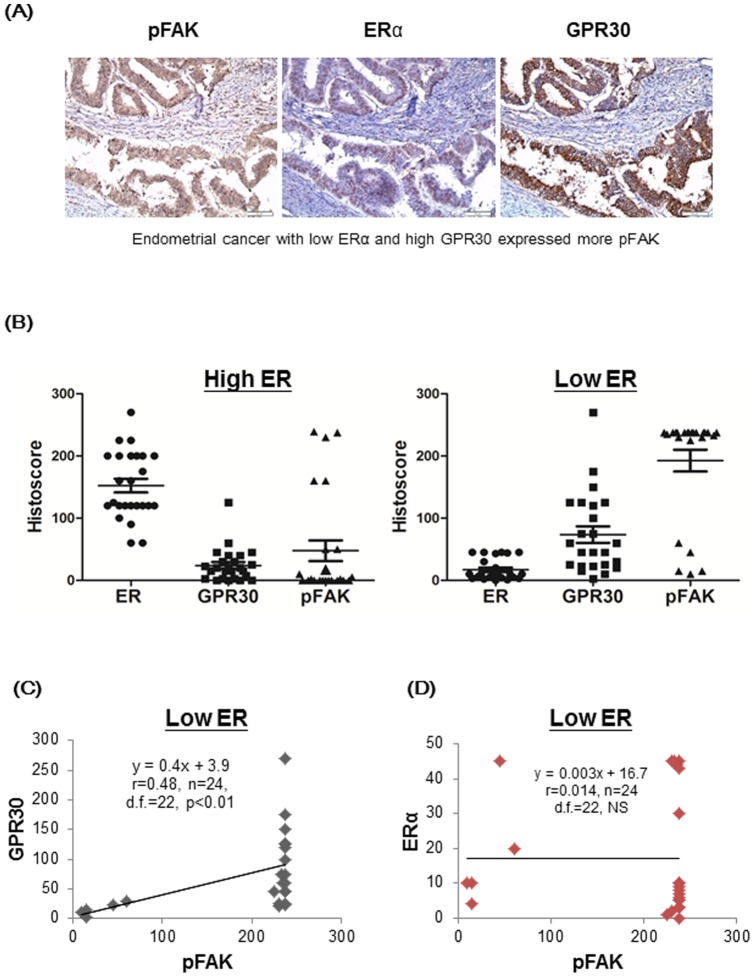
Expression of ERα, GPR30 and pFAK (at Y397) in human endometrial cancers with low ERα.(A) In clinical samples of human endometrial cancers with low expression of ERα (histoscore  = 10), relatively high expression of GPR30 (histoscore  = 270) and pFAK (histoscore  = 225) were observed (40× magnification of the object lens). (B) The histoscores of both GPR30 and pFAK were lower in human endometrial cancers with high ER (histoscore >45, left panel) as compared to those with low ER (histoscore ≤45, right panel). (C) There was a positive correlation of histoscores between pFAK and GPR30 in human endometrial cancers with low ERα. (D) No association was found in histoscores between pFAK and ERα in human endometrial cancers. NS: not significant.